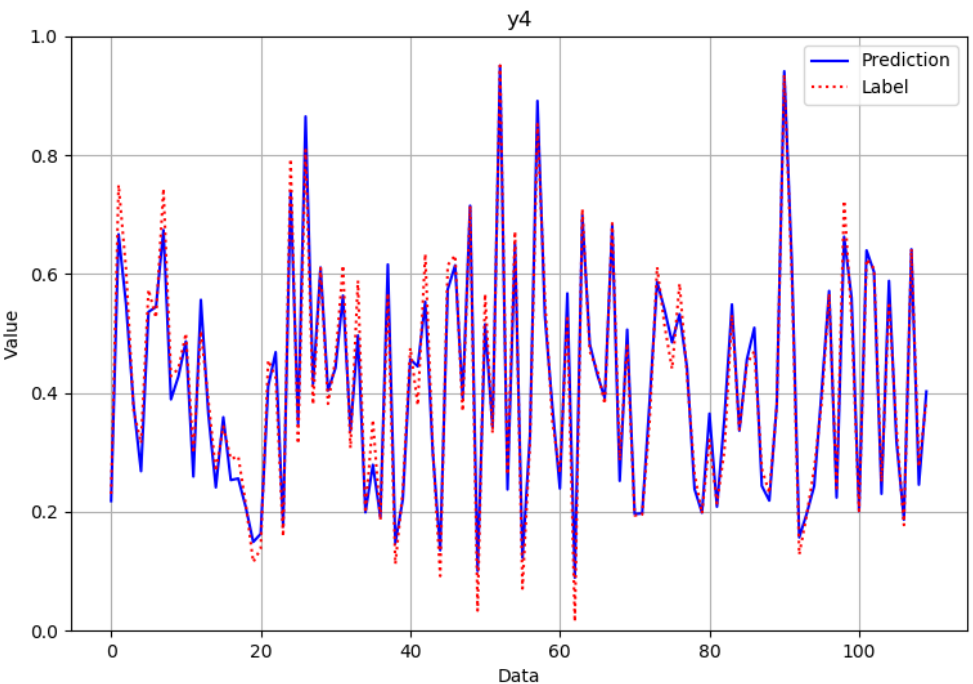
Figure 15. Comparison of predicted and actual values in the modulus of resilience verification data set after normalization.